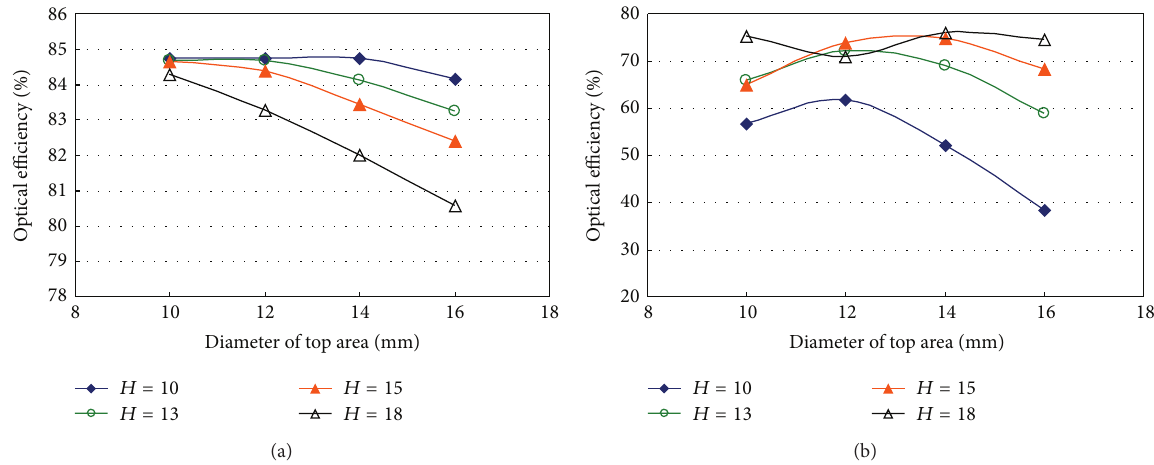
Figure 6: Effects of refractive cone SOE parameters on the optical efficiency: (a) incidence angle = 0 ∘ (normal incidence) and (b) incidence angle = 1 ∘ .